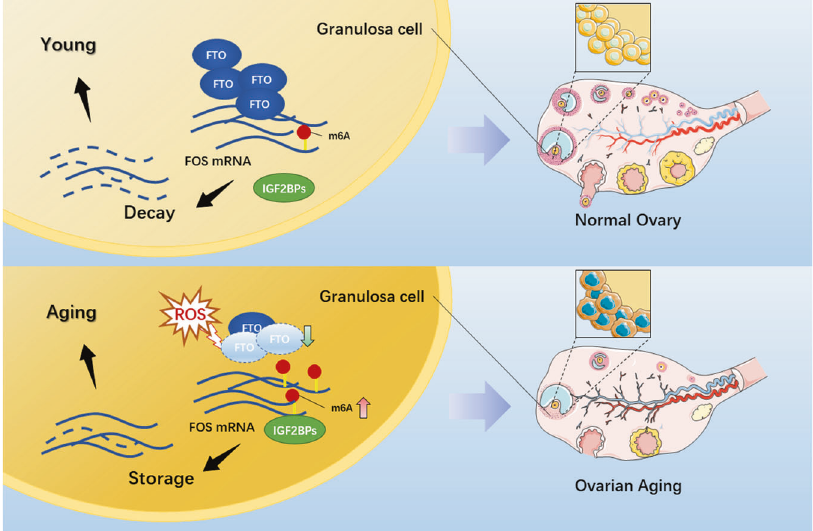
Fig. 7 Working model. The role of FTO as an m6A demethylase in ovarian aging. Aging-related factors (ROS) downregulate the demethylase FTO in ovarian granulosa cells, which can enhance FOS-mRNA stability by increasing m6A in the FOS-mRNA-3 ′ UTR to upregulate FOS expression, thus leading to ovarian aging.